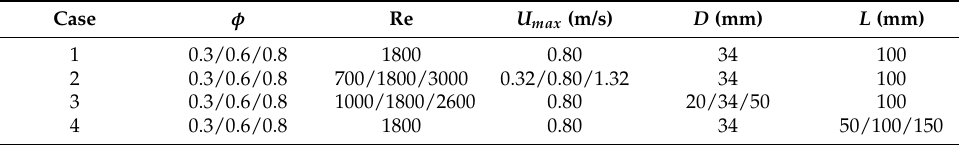
Table 2. Vortex flow model parameters and conditions for the simulation